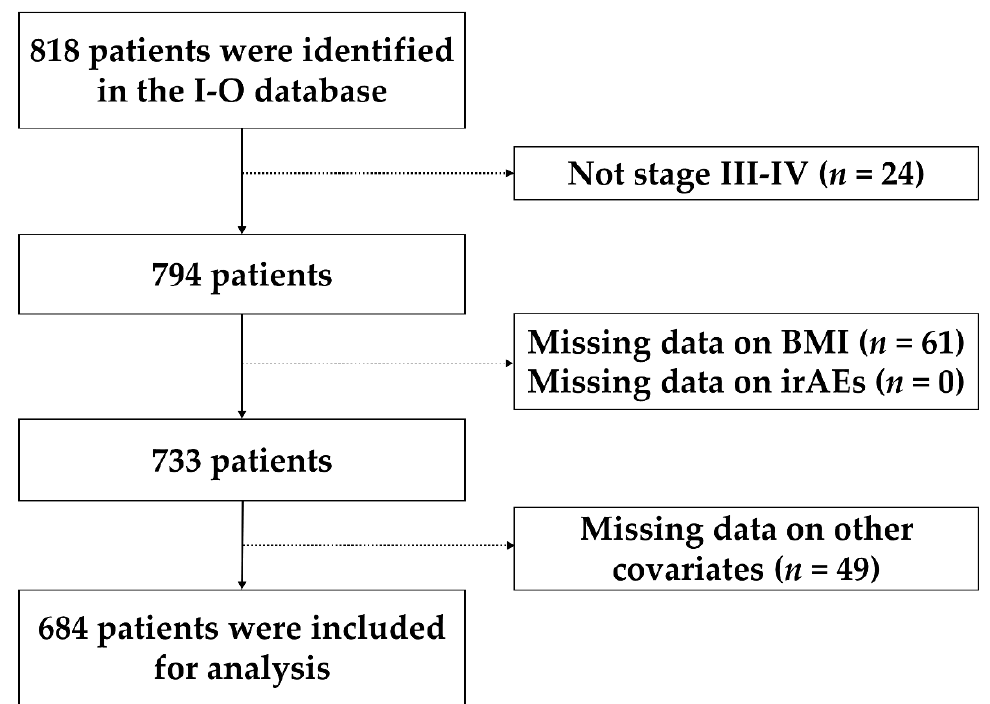
Figure 1. Flowchart for study participants selection. Abbreviations: BMI: body mass index, irAEs: immune-related adverse events.